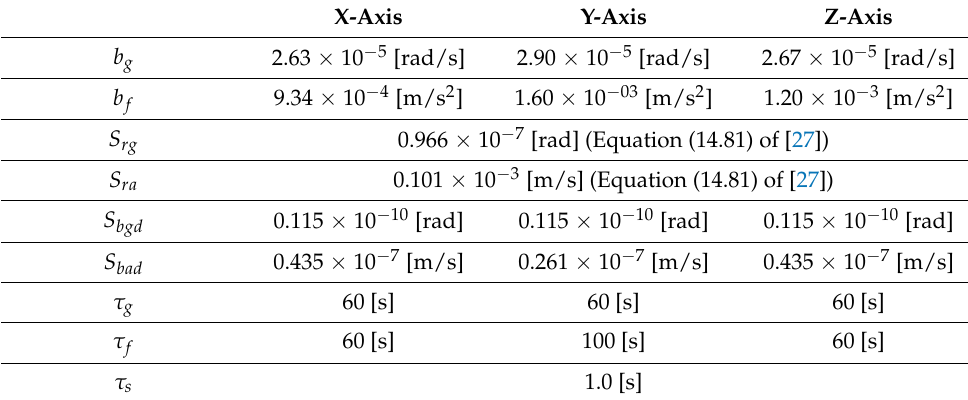
Table 2. Summary of the converted input data.